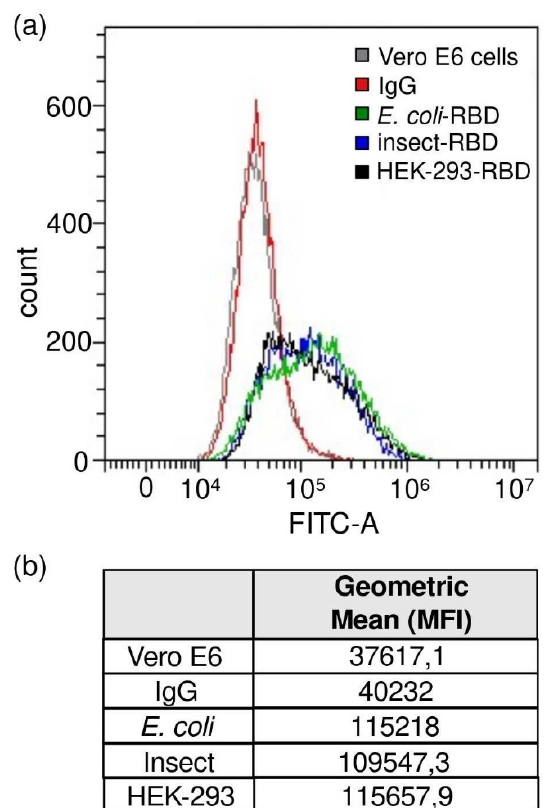
Figure 4. Flow cytometry assays. RBD-Vero E6 cells binding experiment. ( a ) Gray curve, Vero E6 cells alone; red curve, Vero E6 cells incubated with only secondary antibody; green curve, Vero E6 cells incubated with E. coli -RBD; blue curve, Vero E6 cells incubated with Insect-RBD; black curve, Vero E6 cells incubated with HEK-293-RBD. Incubation with RBD was followed by anti-RBD primary antibody and secondary antibody. ( b ) Intensity of the staining measured as geometric mean (median fluorescence intensity, MFI) value.